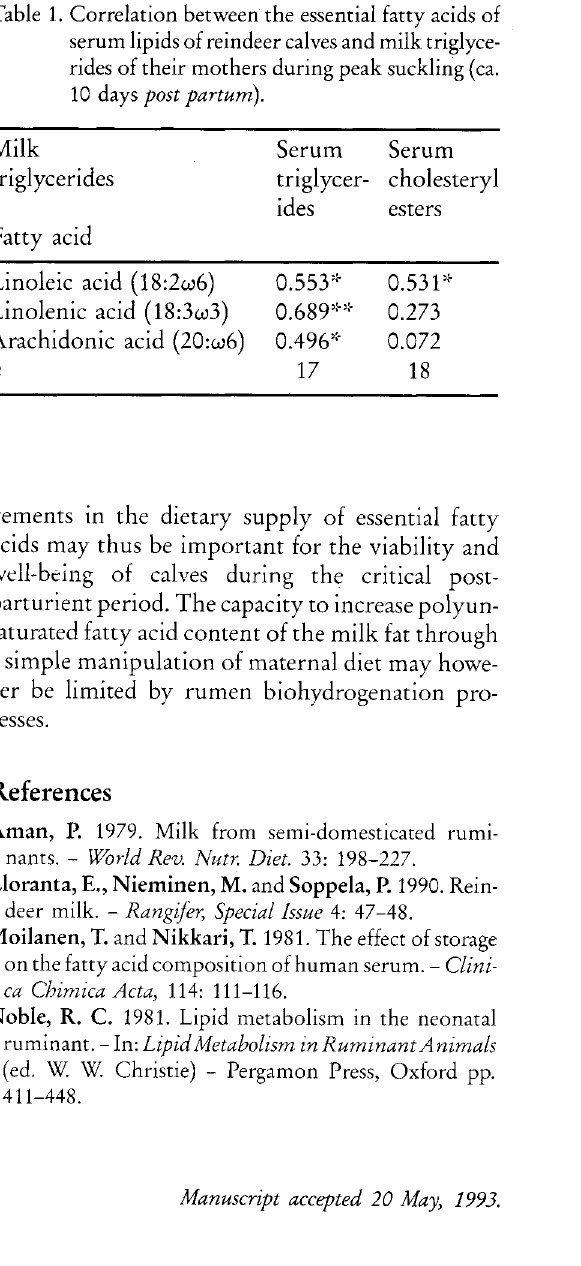
Table 1. Correlation between the essential fatty acids of serum lipids of reindeer calves and milk triglyce rides of their mothers during peak suckling